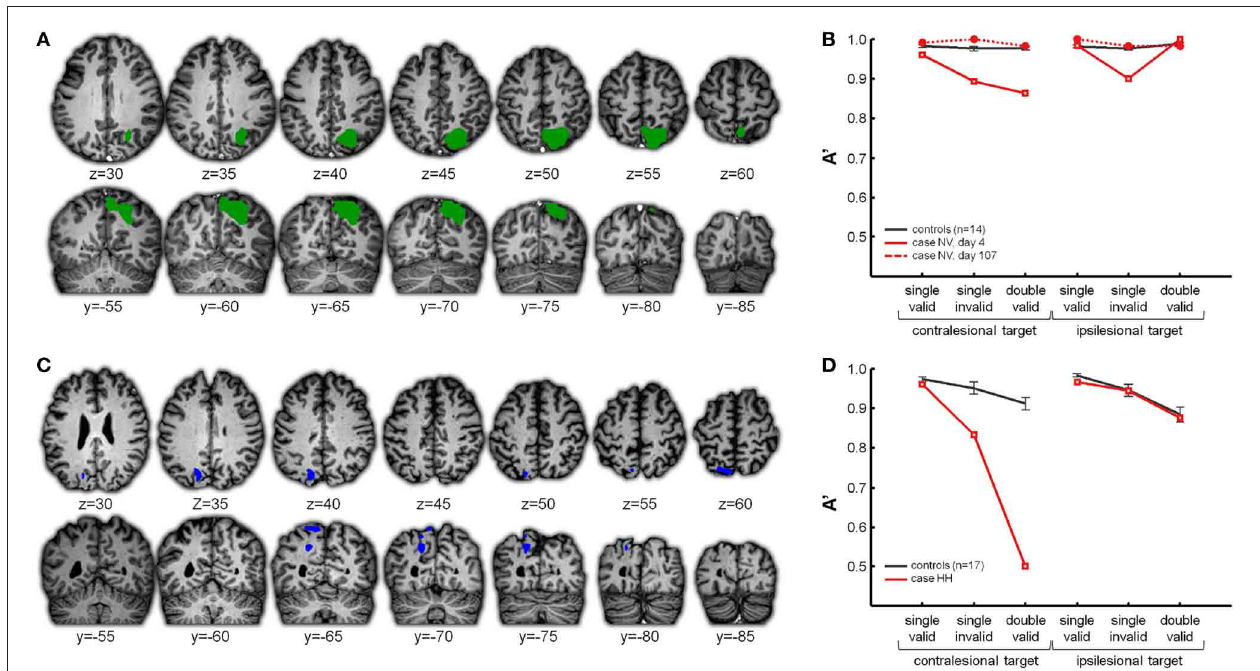
FIGURE 2 | (A,B) Case NV. (A) In green the right middle IPS lesion in case NV, affecting the horizontal segment of IPS with extension into the superior parietal lobule. (B) NV’s accuracy (expressed as A (cid:2) ) obtained in the different conditions of the hybrid spatial cueing paradigm (red), compared to age-matched controls (black). NV was tested on two instances. On day 4